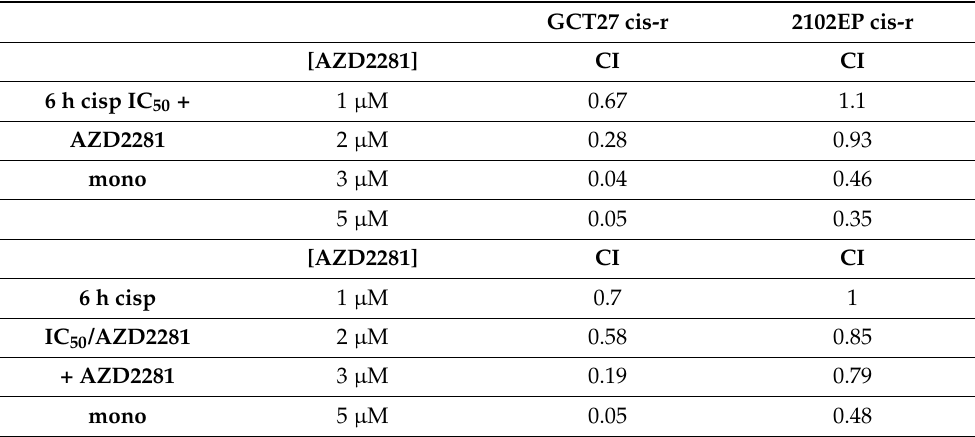
Table 4. Combination index (CI) of cisplatin/AZD2281 combined therapies. Top row: combined sequential (cisplatin>AZD2281) monotherapies (mono). Bottom row: concomitant administration of cisplatin and AZD2281 for 6 h, followed by AZD2281 monotherapy. Cisplatin (cisp) concentration was equal to the IC 50 value; AZD2281 concentrations are